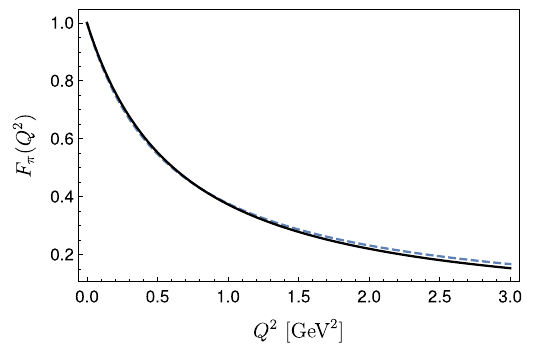
between the lattice eff (23) (full black line) and its approximation (24) (dashed blue line). Dotted green lines stand for the approximation (24) evaluated in the IMF, see Eq.